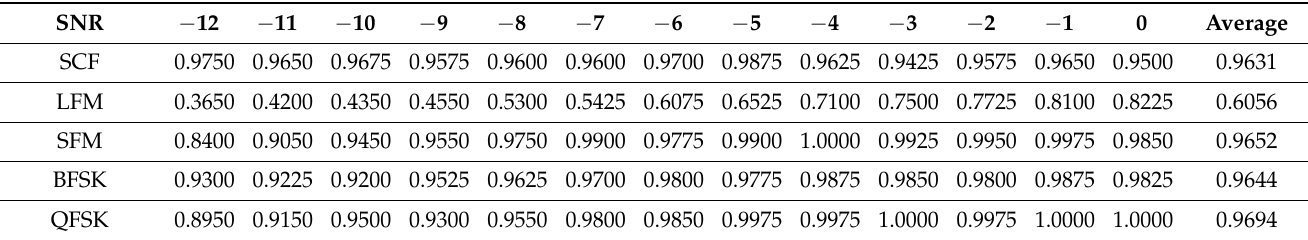
Table A7. Semi-supervised classification results with the datasets in Situation Dataset 5 ( T cycle = 26, NUM =